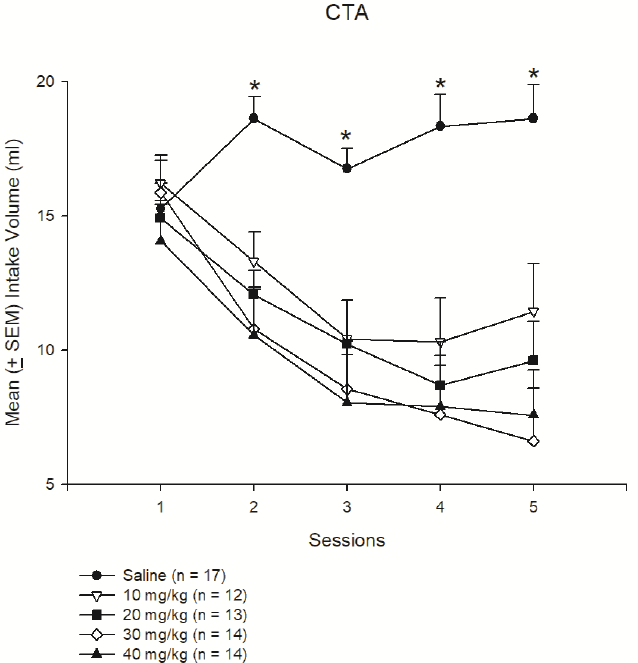
Figure 2. Morphine was acting as an unconditioned stimulus agent in conditioned suppression of intake of a 0.1% saccharin solution. Mean ( ± SEM) intake volume of 0.1% saccharin solution in rats injected with saline ( n = 17) or with morphine in doses of 10 mg/kg ( n = 12), 20 mg/kg ( n = 13), 30 mg/kg ( n = 14), and 40 mg/kg ( n = 14) over 5 sessions. * p < 0.05 when comparing the saline groups and the various morphine groups.